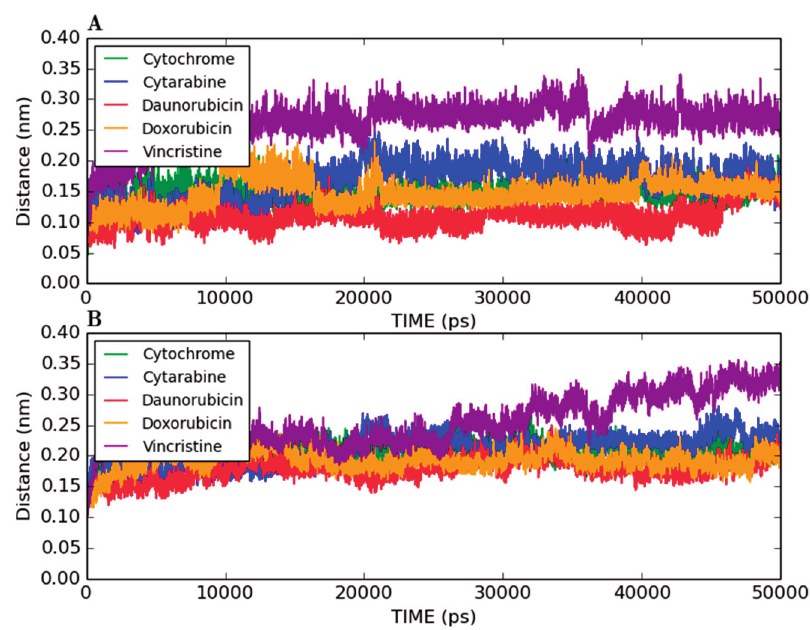
Figure 3. MD analysis of loops. ( A ) RMSD of the phenylalanine loop (F108, F219, F220, F241 and F304); and ( B ) F–G connecting loop (209–217) for the productive binding pose of cytarabine, daunorubicin, doxorubicin and